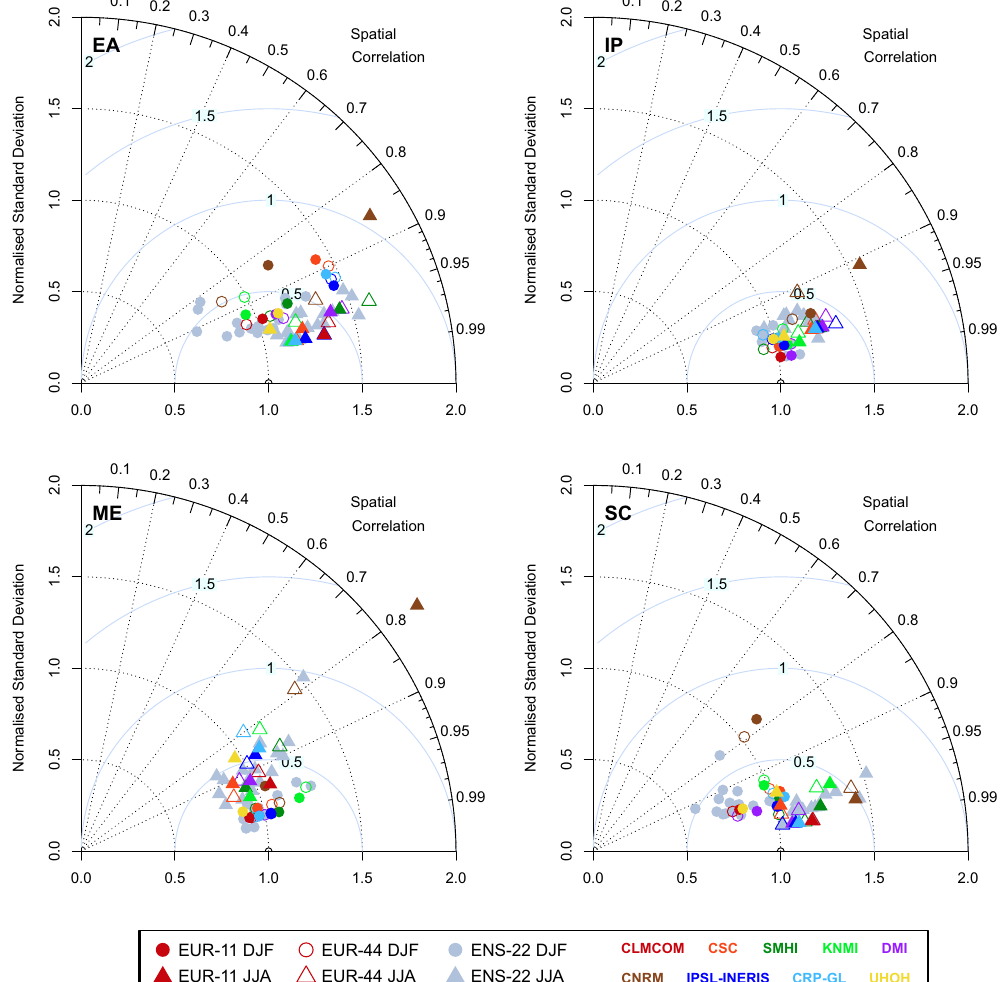
Figure 9. Spatial Taylor diagrams exploring the model performance with respect to the spatial variability of mean winter (circles) and mean summer (triangles) temperature within subdomains EA, IP, ME and SC (see Fig. B5 for subdomains AL, BI, FR and MD). Filled markers: EUR-11 ensemble, nonfilled markers: EUR-44 ensemble, gray markers: ENS-22 ensemble. The diagrams combine the spatial pattern corre- lation (PACO, cos(azimuth angle)) and the ratio of spatial variability (RSV, radius). The distance from the 1–1 location corresponds to the normalized and centered root-mean-square difference (which does not take into account the mean model bias), expressed as multiples of the observed standard deviation. Note the different number of underlying grid cells per subdomain in the individual